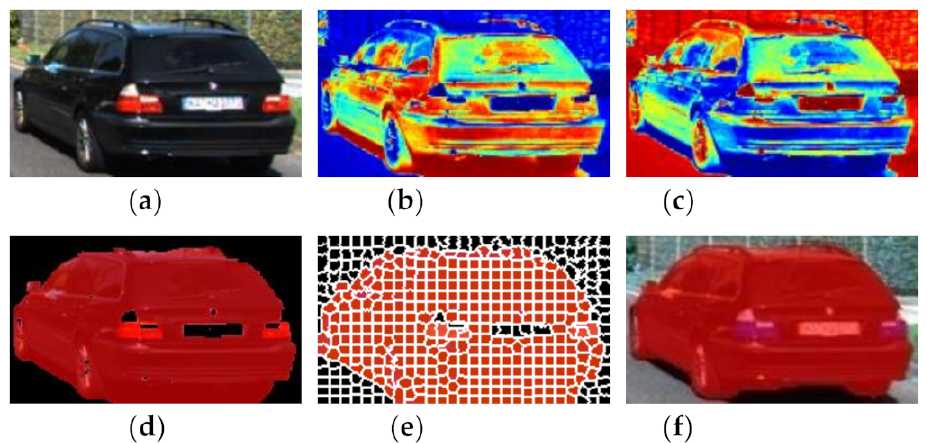
Figure 3. An illustration of object/background confidence maps and segmentation results. ( a ) Bound- ing box detected by YOLO-v4. ( b ) Foreground confidence map. Red represents higher confidence value while blue represents lower value. ( c ) Background confidence map. ( d ) Segmentation result generated by GrabCut. ( e ) Super-pixels generated by Simple Linear Iterative Clustering. ( f ) Segmen- tation result after applying